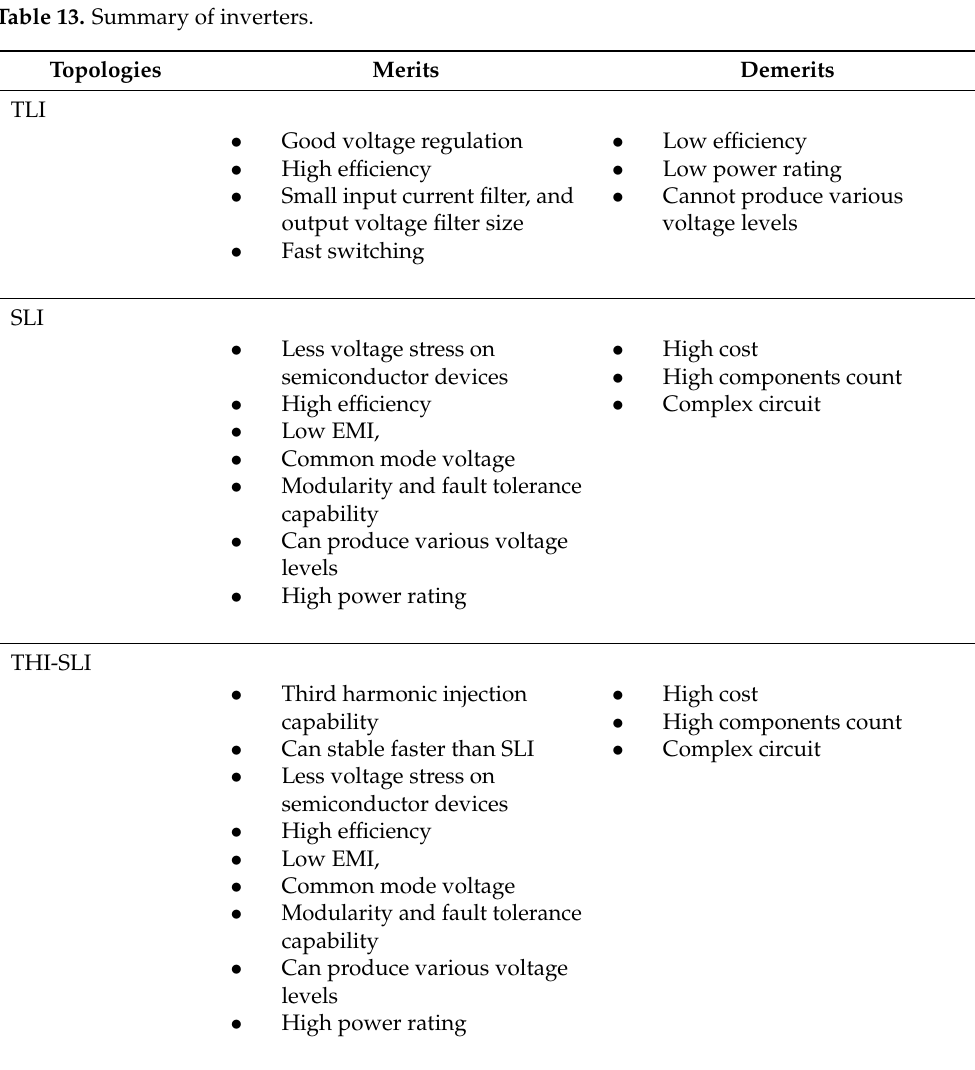
Table 13. Summary of